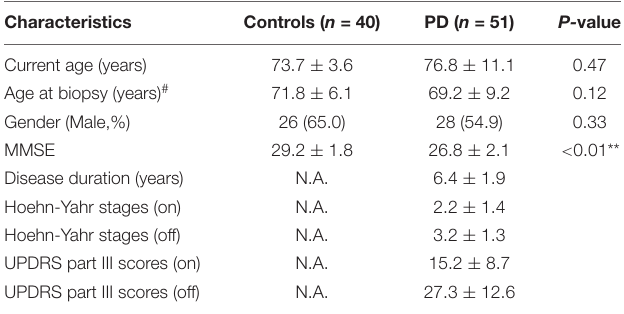
TABLE 1 | Clinical characteristics of all participants in the current study.